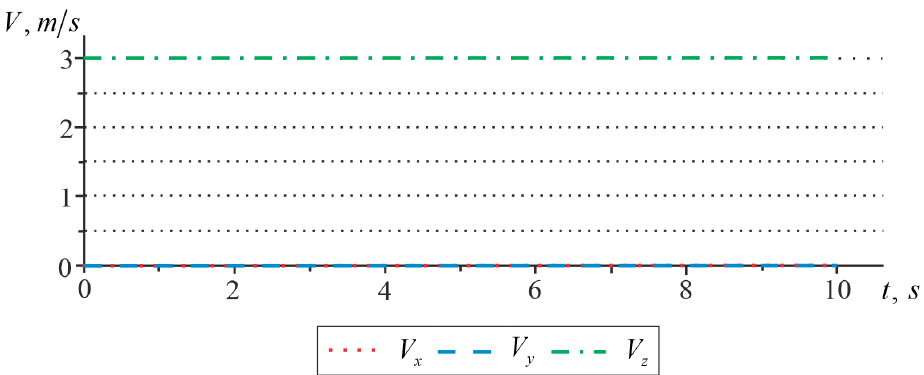
Figure 13. Estimates of the components of the velocity vector during vertical takeoff.